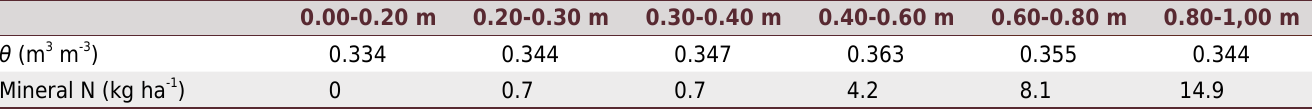
Table 2. Initial values of soil water content ( θ ) and mineral nitrogen